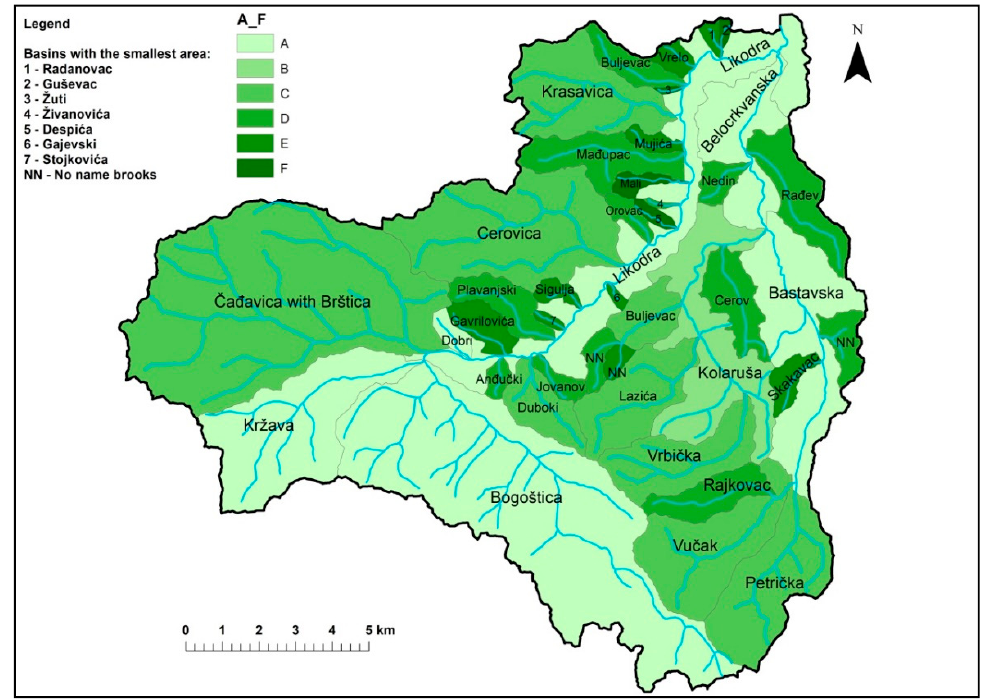
Figure 5. Hydrographic classes in the Likodra river basin.